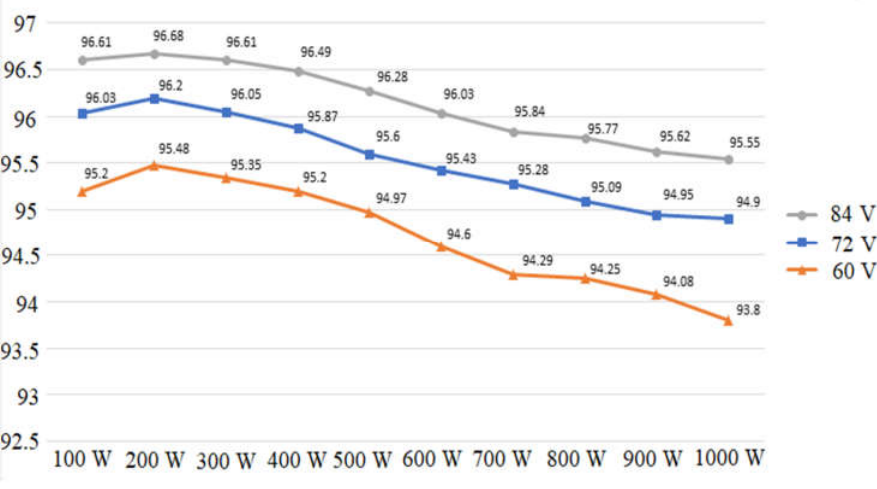
Figure 19. Power efficiency of the CADPCI under different battery voltages. Table 2. Merits of the proposed CADPCI of prototype.